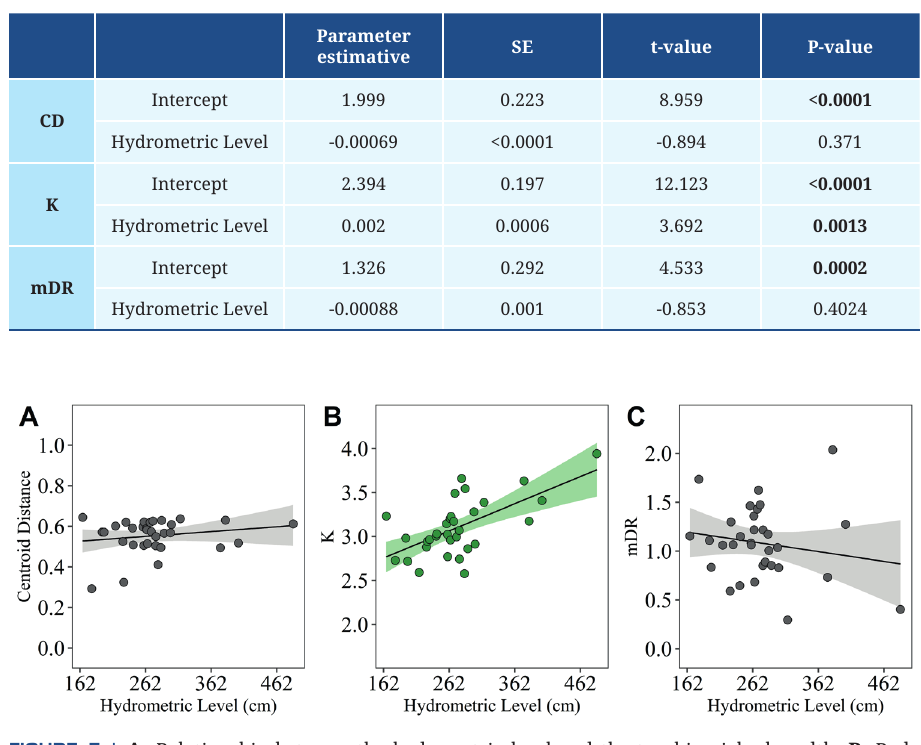
TABLE 3 | Results of generalized linear mixed model analysis for Centroid Distance (CD), K and mDR values of Trachelyopterus galeatus with hydrometric level. SE = Standard Error.